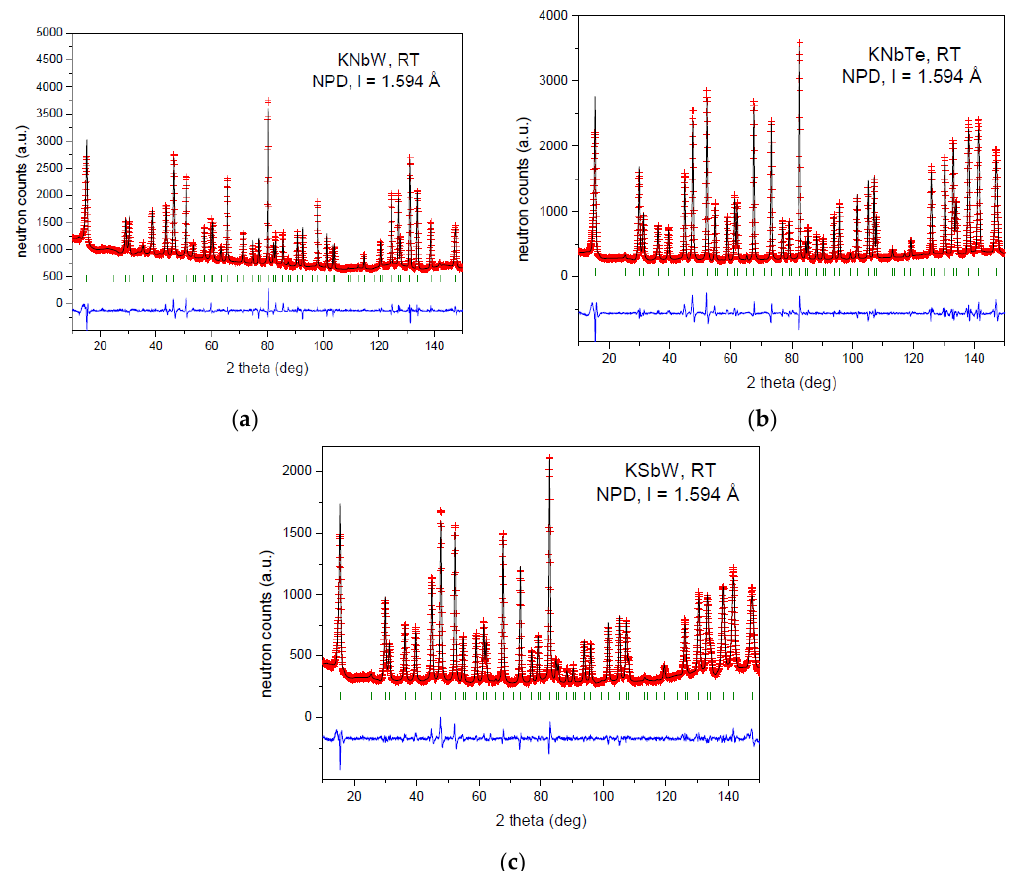
Figure 3. NPD analysis of the three pyrochlore samples for ( a ) KNbW, ( b ) KNbTe and ( c ) KSbW samples. Experimental NPD data are represented with red crosses, the solid line shows the calculated profile, and their difference is presented at the bottom (blue line). Vertical green bars indicate the permitted peak positions.